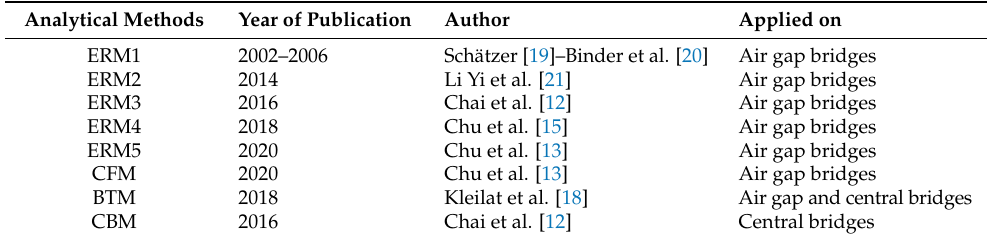
Table 1. Analytical methods proposed in the literature for determining the maximum mechanical stress of an IPMSM.